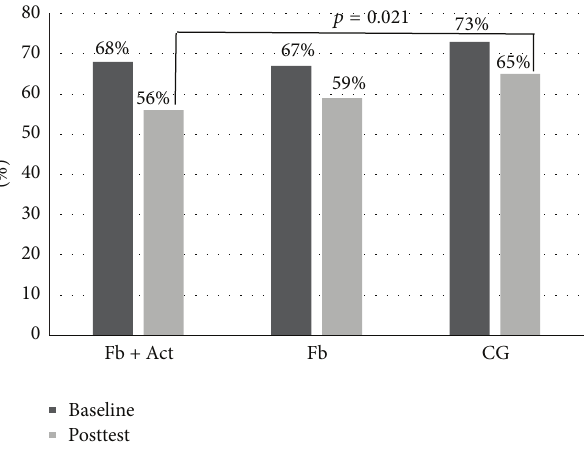
Figure 2: Daily time spent engaged in sedentary or very light physical activity on weekdays (%) at baseline and